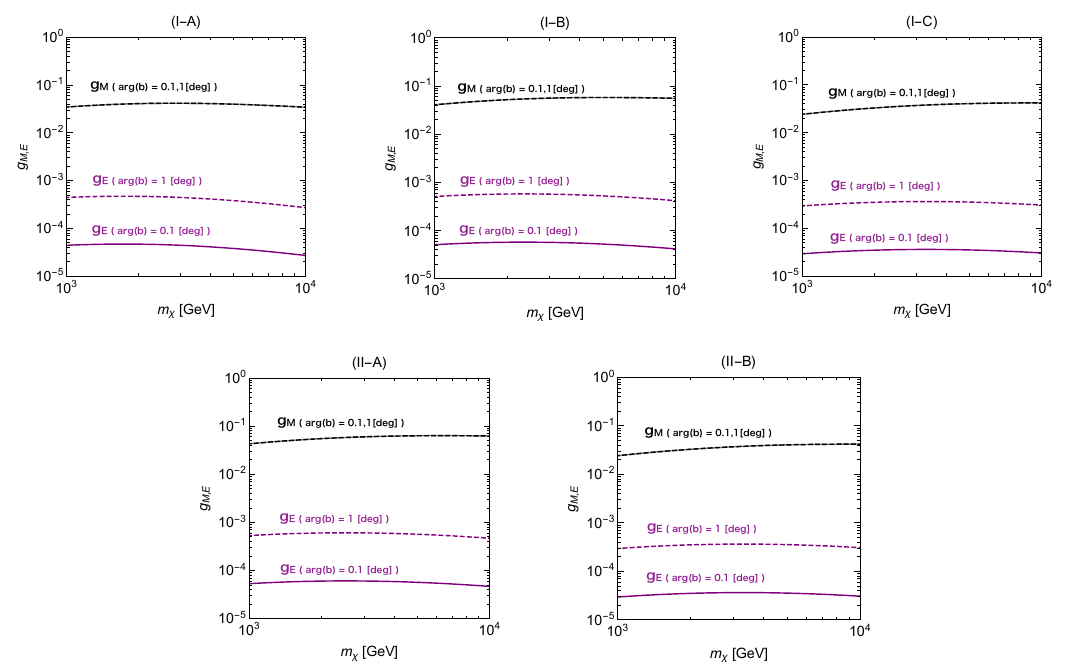
Figure 2 . DM-MDM and DM-EDM, g and purple lines, respectively. We take a =